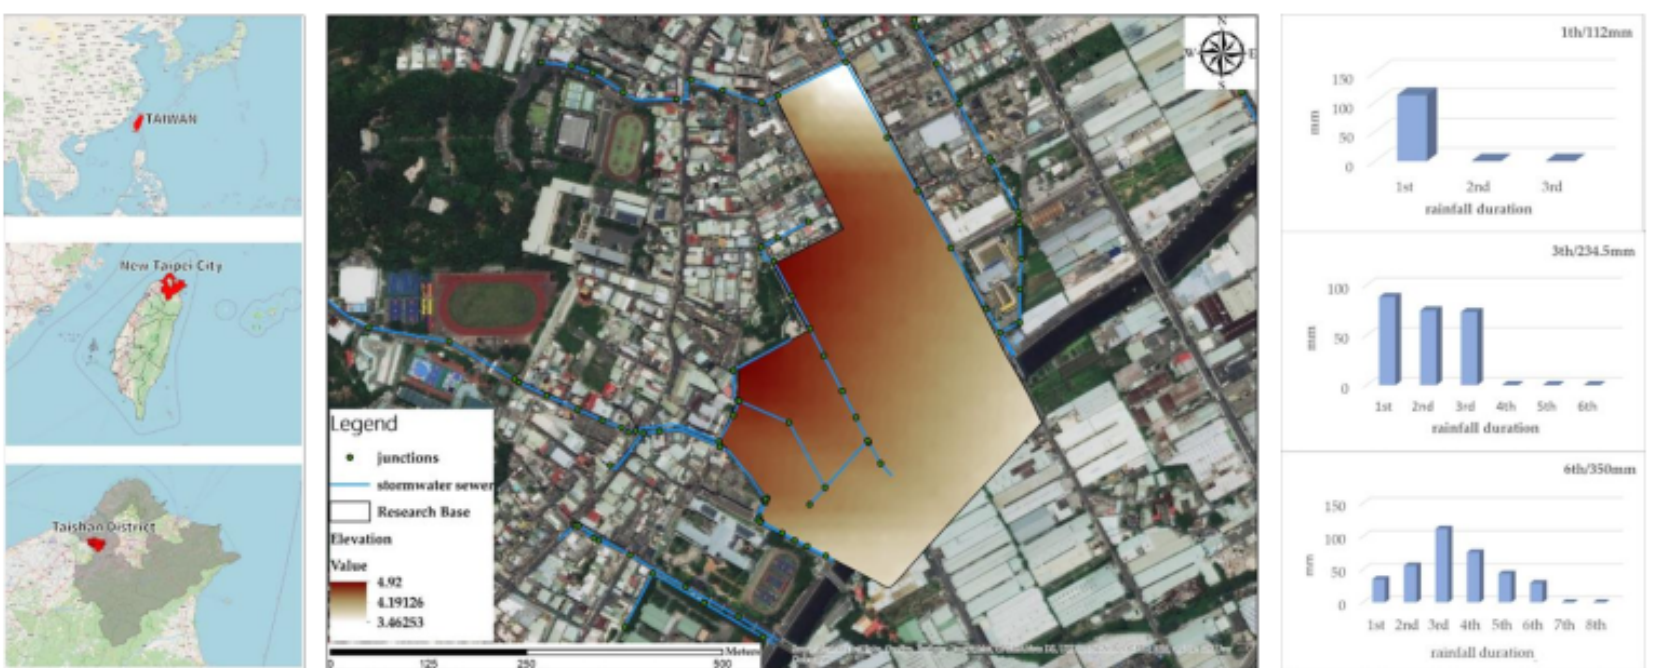
Figure 2. Schematic diagram of elevation and the main stormwater